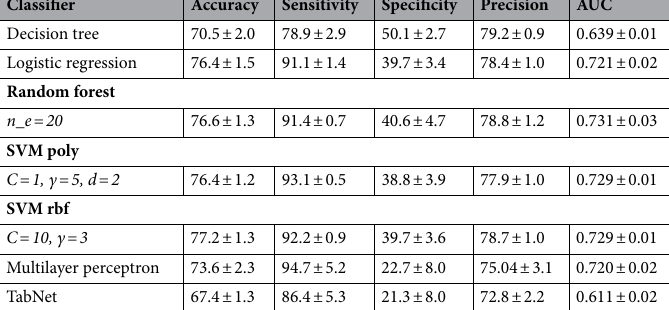
Table 4. Predictive Performance of the models.